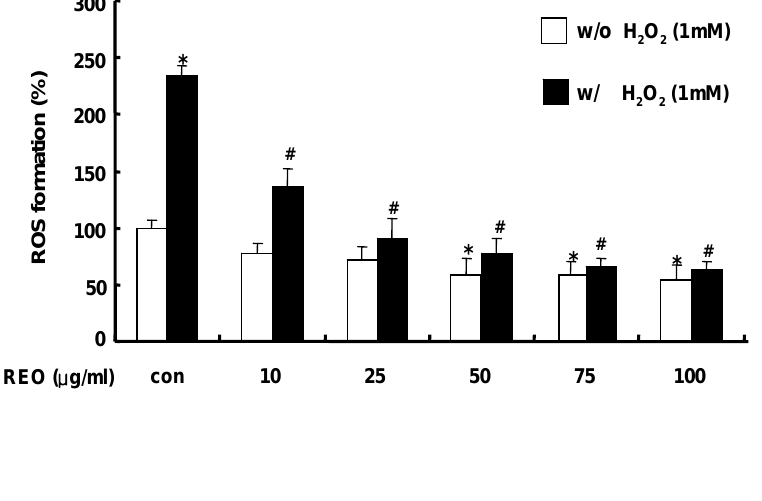
O -induced reactive oxygen 2 2 O . Values are 2 2 O . # p < 0.05, significantly different from the 2 2 O 2 2